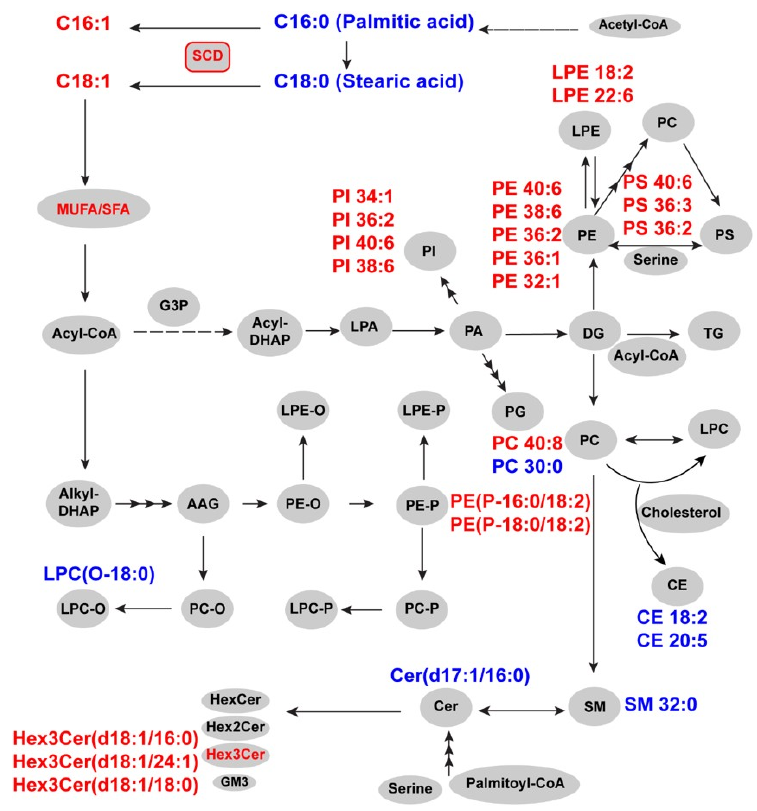
Figure 5. Mapping of molecular alterations in OCCC onto lipid metabolism pathways.